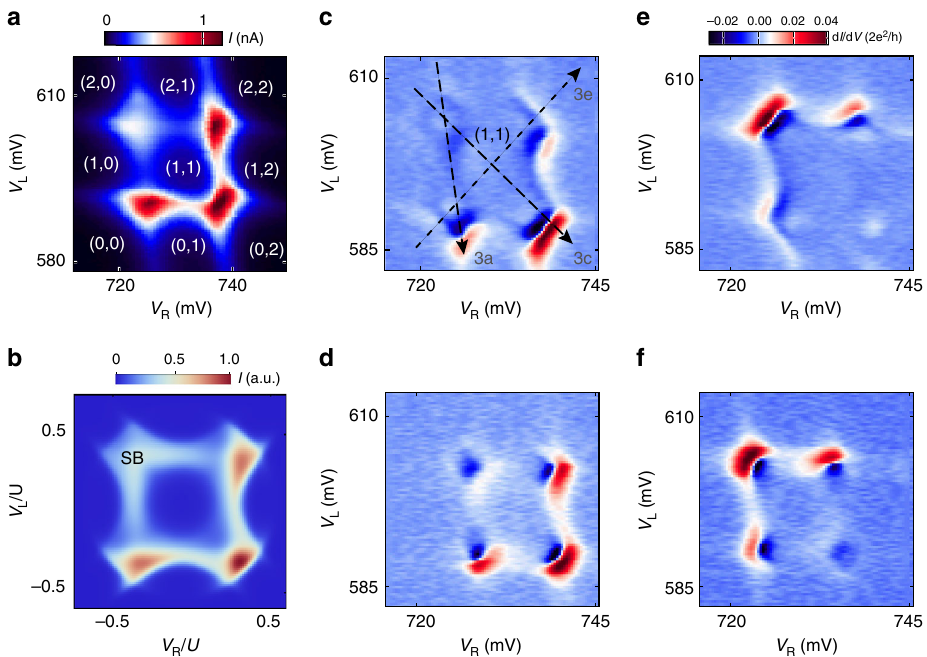
Fig. 2 Stability diagrams. a Current at V bias = 200 μ V as a function of left and right gate voltages ( V L and V R ). Parities of double dot con fi gurations are indicated in brackets. b Numerically computed current at low interdot tunneling as a function of chemical potentials of left and right dots over charging energy U . “ SB ” marks the corner with numerically reproduced spin blockade. c Differential conductance d I /d V at V bias = 200 μ V over the same gate voltage range as in a . Dashed lines indicate the cuts that correspond to panels in Fig. 3. d – f Differential conductance d I /d V at V bias = − 200, 50, − 50 μ V over the same gate voltage range as in